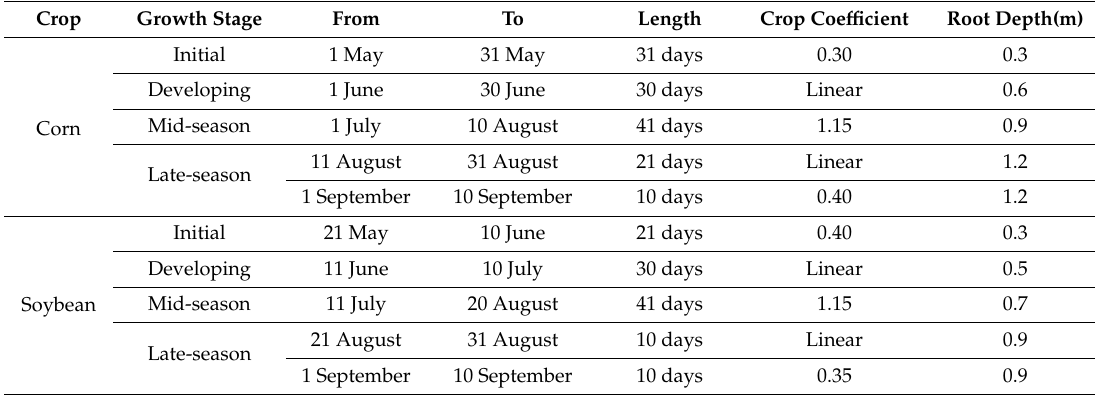
Table 3. Crop coe ffi cients and root depth by growth stages stage.